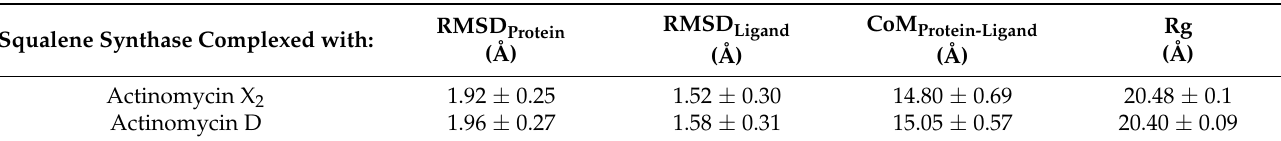
CoM Protein-Ligand RMSD Ligand Rg RMSD Protein (Å) (Å) (Å)